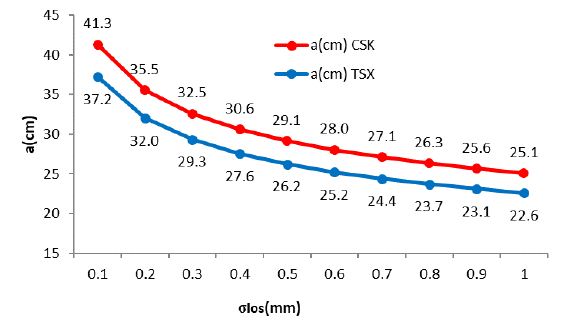
Figure 4. CR size as a function of required LOS